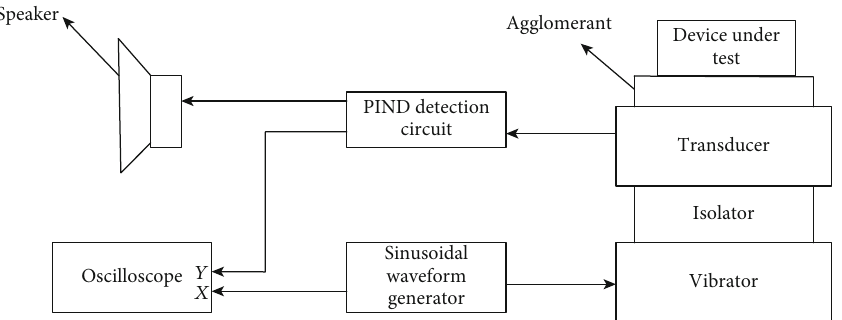
Figure 1: PIND system of